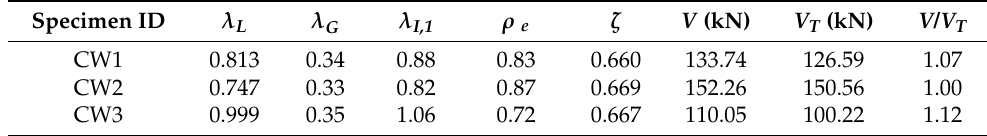
Table A12. Analysis results of test specimens reported by Johnson and Cafolla